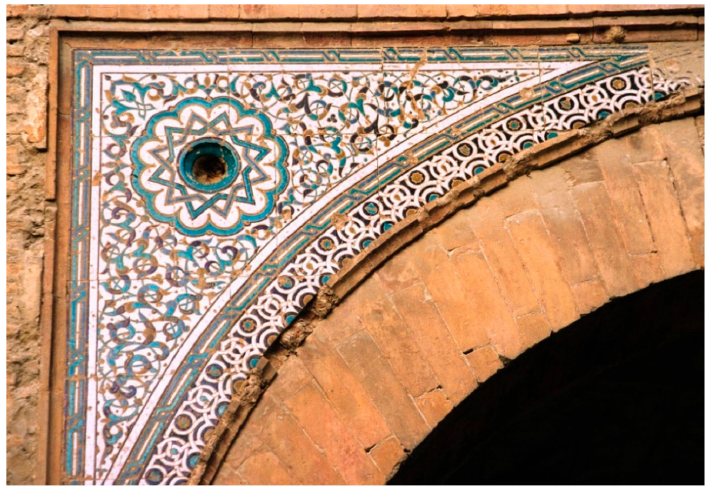
Figure 9. Cuerda seca ceramics on the spandrels at the Wine Gate (Puerta del Vino). © Mar í a Elena D í ez Jorge, 2014.